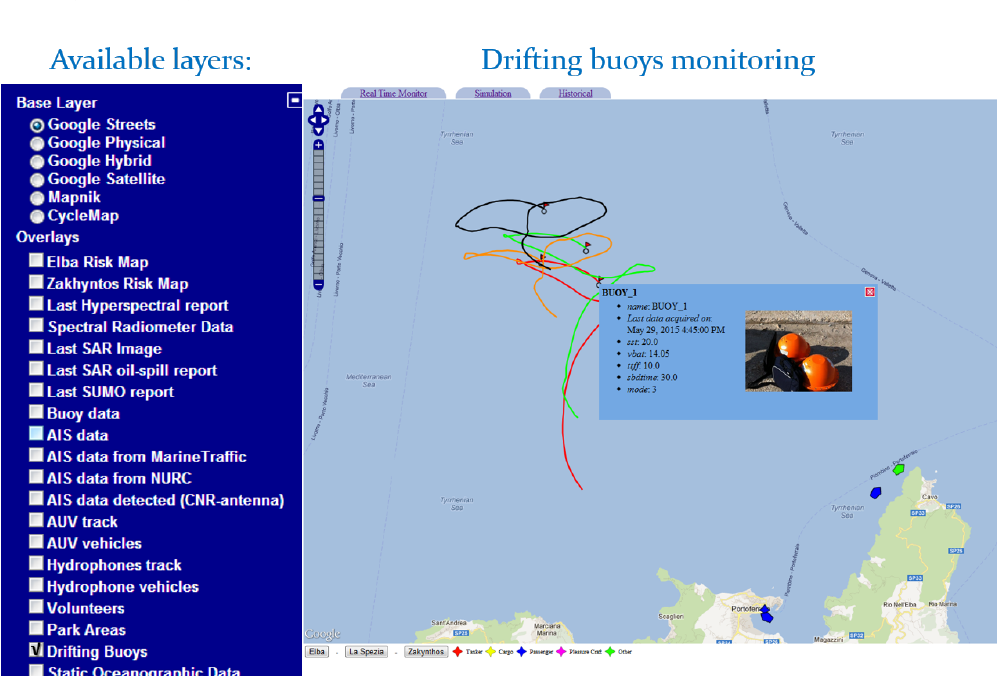
Figure 5. MIS interface showing acquired data from drifting buoys sensors as an overlay layer on the map. (scale 1 cm:2